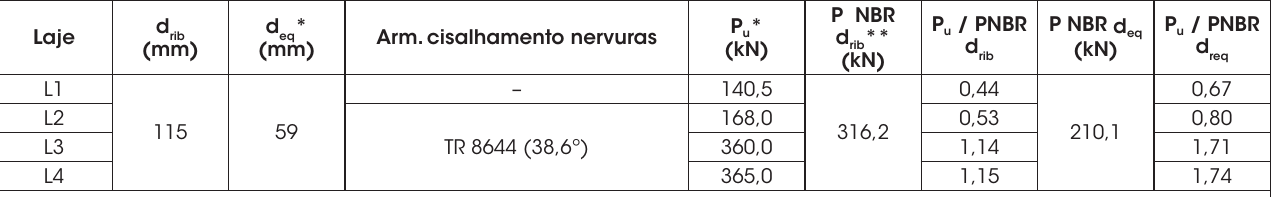
e L4. Com base nos resultados experimentais, algumas